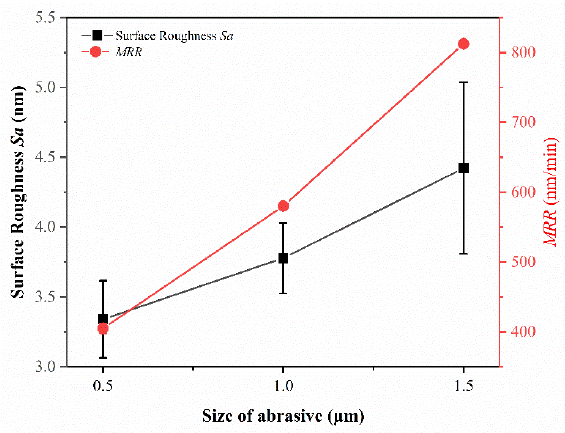
Figure 5. Effect of size of abrasive on the surface roughness and MRR of polished samples.